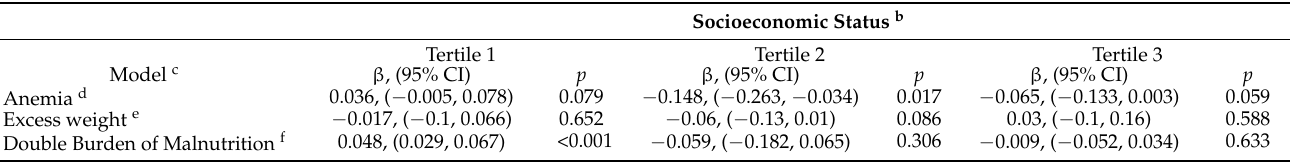
Table 4. Pseudo-panel analysis a of the association between the dietary intake of ultraprocessed products and health conditions in a cohort of Mexican